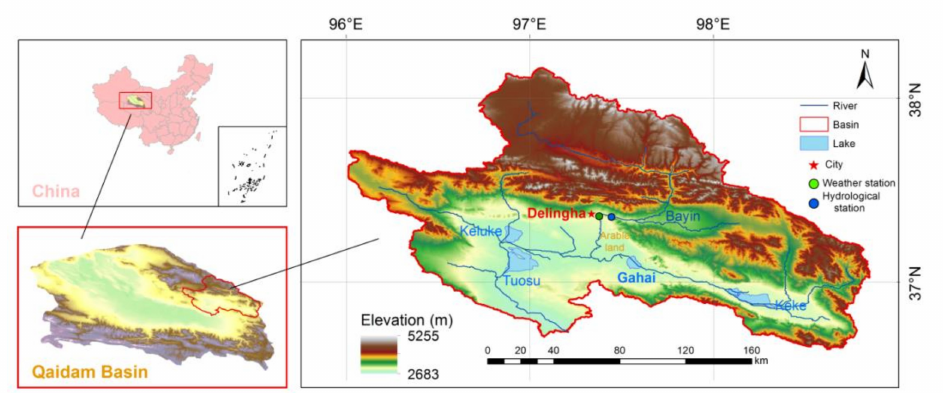
Figure 1. Location of the Gahai Lake within the Qaidam